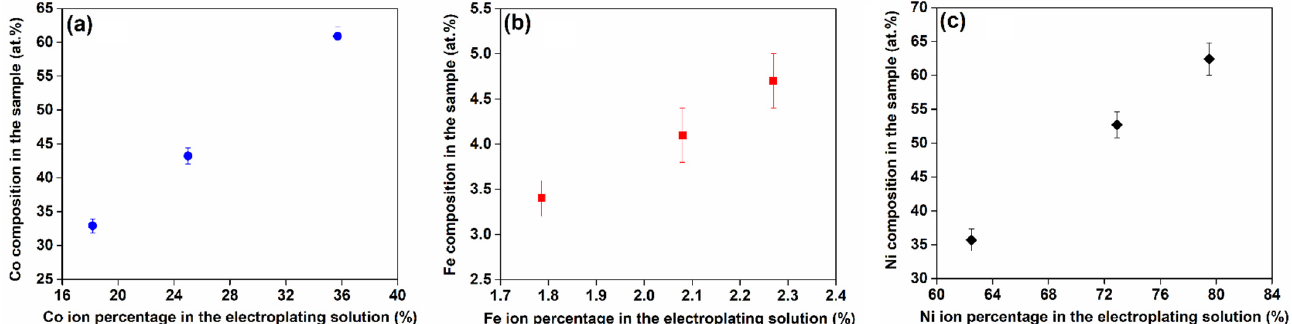
Figure 2. The relative Co ( a ), Fe ( b ), and Ni ( c ) composition in the samples against the relative Co (Fe and Ni) ion percentage in the PSs.